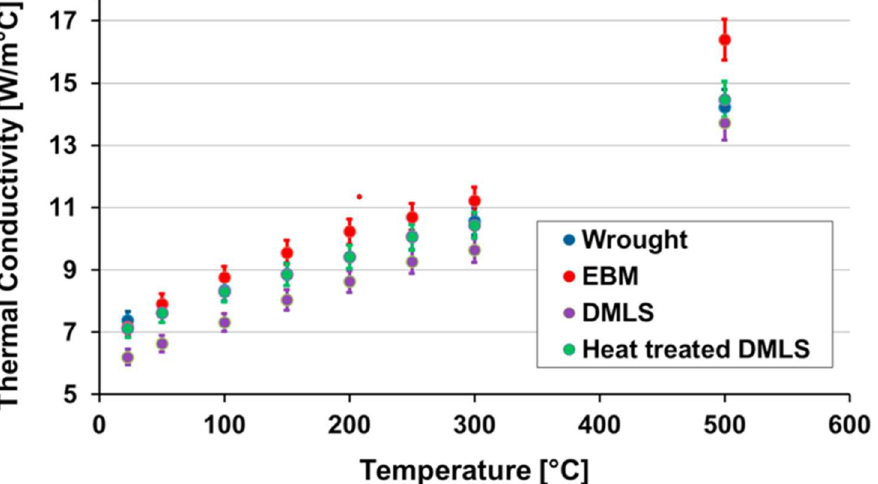
Figure 15. Effect of temperature on the thermal conductivity of Ti-6Al-4V samples under different cu(cid:308)ing conditions [119] (Reprinted with permission from [119]. Copyright 2017, Elsevier).